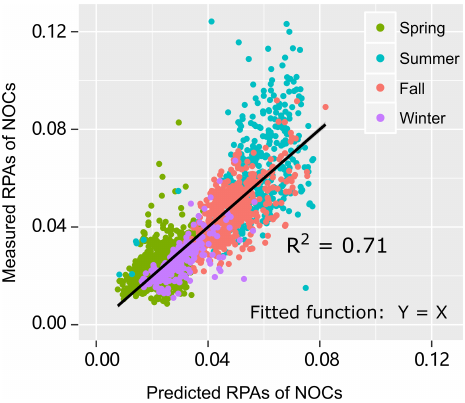
Figure 4. Comparison between the measured and predicted RPAs for